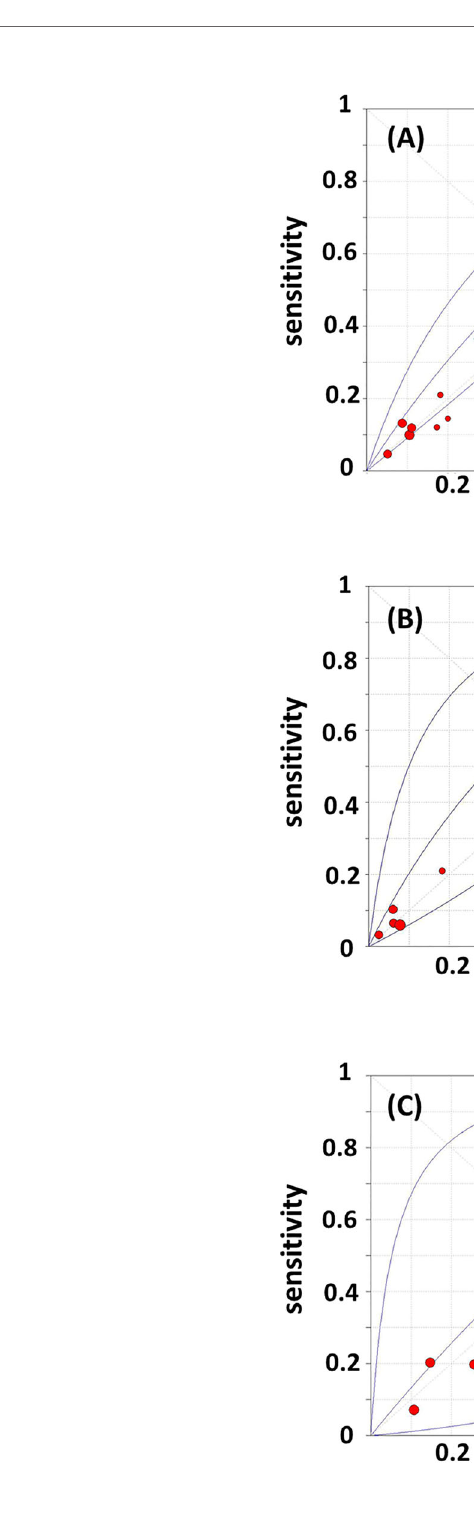
Frontiers in Endocrinology |